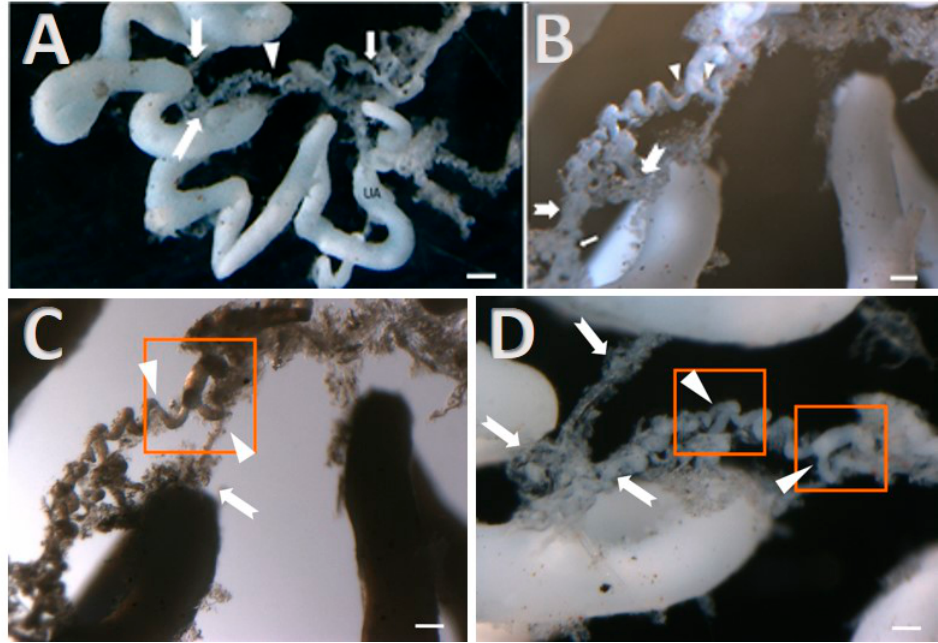
Figure 2. ( A ) Vascularization images of mare oviduct depicted by means of the injection-corrosion technique. On the left panel, one can observe the uterine artery (UA), the isthmus vascularization (arrow), the ampulla vessels (arrowhead) and vascularization of the infundibulum (indented arrow), bar = 0.33 cm. ( B ) Magnification of the arteries in the ampulla shows that a pattern of dichotomic division is present. These vessels go further into small arterioles (indented arrows) in a coiled configuration, providing vascularization of the infundibulum and fimbria, where ramifications are of the brush or comb type, bar = 0.15 cm. ( C ) Visualization by transillumination shows dichotomy divisions of vessels in the ampulla (orange box, head arrows), bar = 0.15 cm. ( D ) Vessels in the infundibulum are small arterioles that split once again in a dichotomous way (orange square) and process as tuffs of vessels that sprout laterally or in a terminal way in the fimbria (indented arrows), bar = 0.15